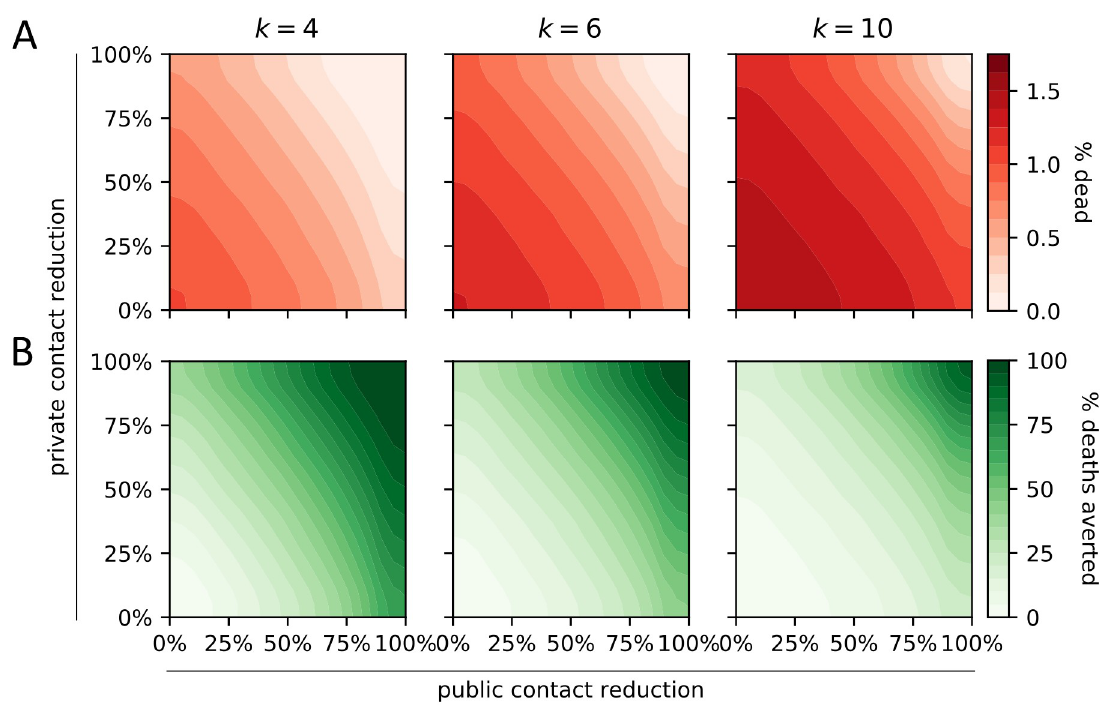
Fig 2. Impact of social distancing on COVID-19-related mortality. Effect of population-wide private and public contact reduction on the average proportion dead (A, red) and the average percentage of averted deaths (B, green). The latter is computed by comparison with no contact reduction. Results are shown for communities with k private and k public average contacts per day, for different values of k .